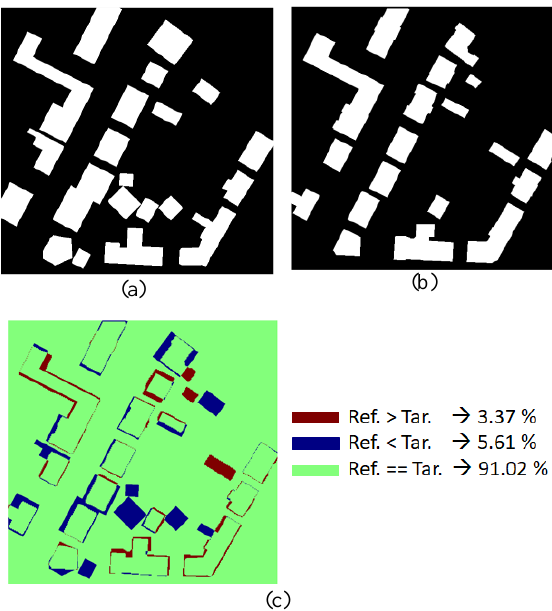
Figure 6. The difference map (c) between the extracted outlines (a) and the ground truth